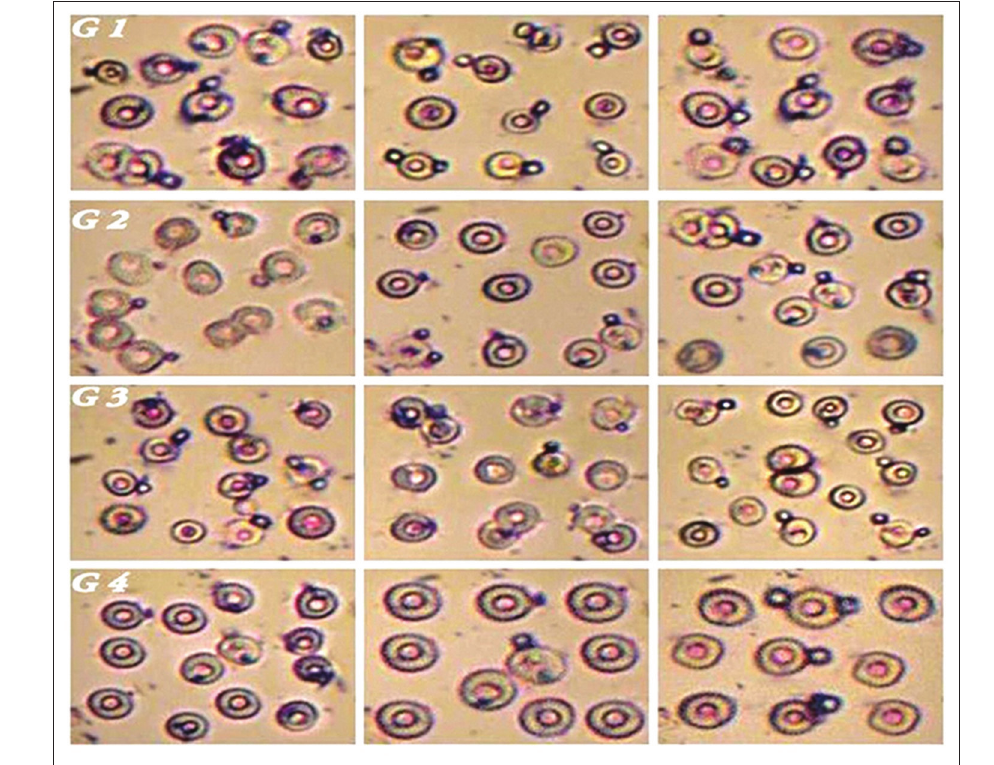
Figure-1: Photograph of phagocyte cells showing the effect of Roundup, Stomp, and both on phagocytic activity of Clarias gariepinus after 15 days of exposure. (G1) Phagocyte cells engulfing yeast cells in C. gariepinus of control group. (G2) Phagocyte cells showing destruction and inhibition of phagocytosis in group exposed to Roundup. (G3) Phagocyte cells showing destruction and inhibition of phagocytosis in group exposed to Stomp. (G4) Phagocyte cells showing severe destruction and inhibition of phagocytosis in group exposed to combination of Roundup and